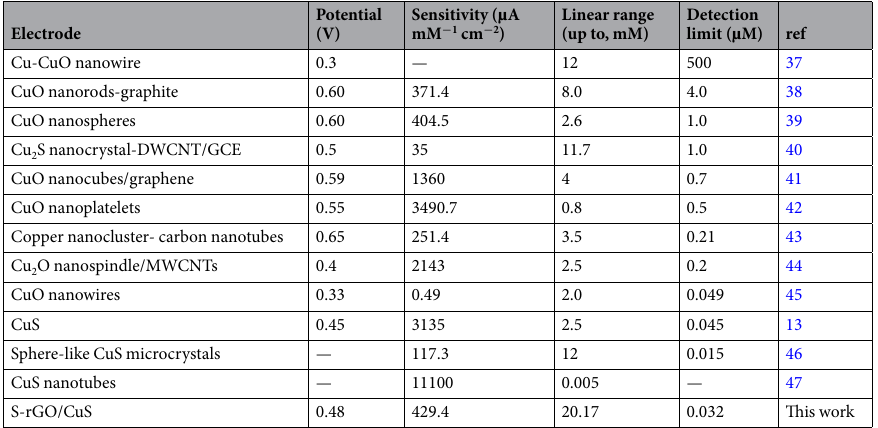
Table 1. Comparison of the analytical performance of the S-rGO/CuS sensor electrode with previously reported non-enzymatic glucose sensor